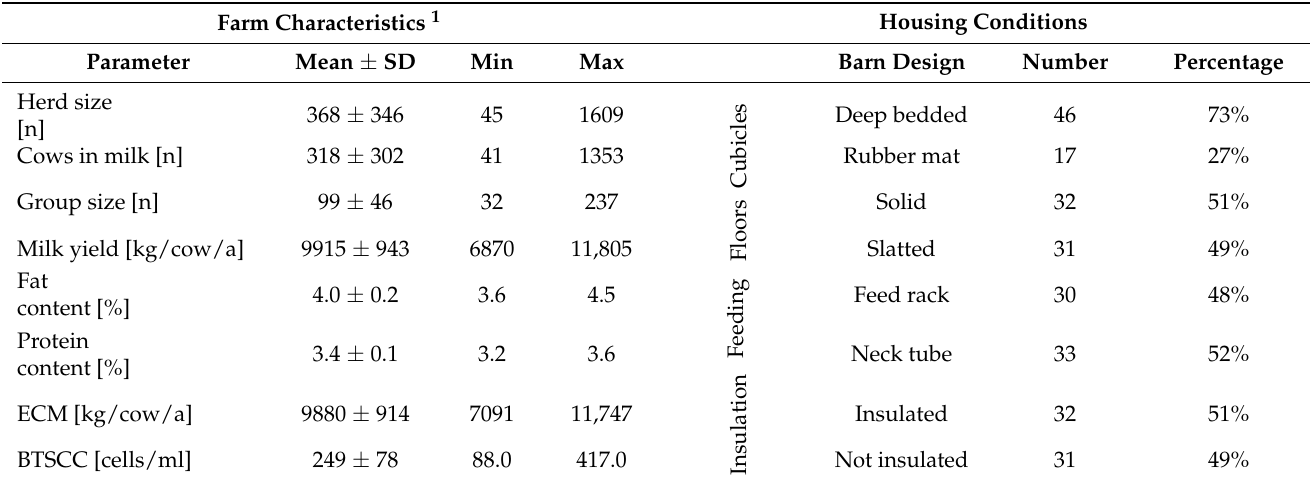
Table 1. Farm characteristics (mean, standard deviation, minimum, maximum) and housing condi- tions (number of farms, percentage of farms) of 63 dairy cattle